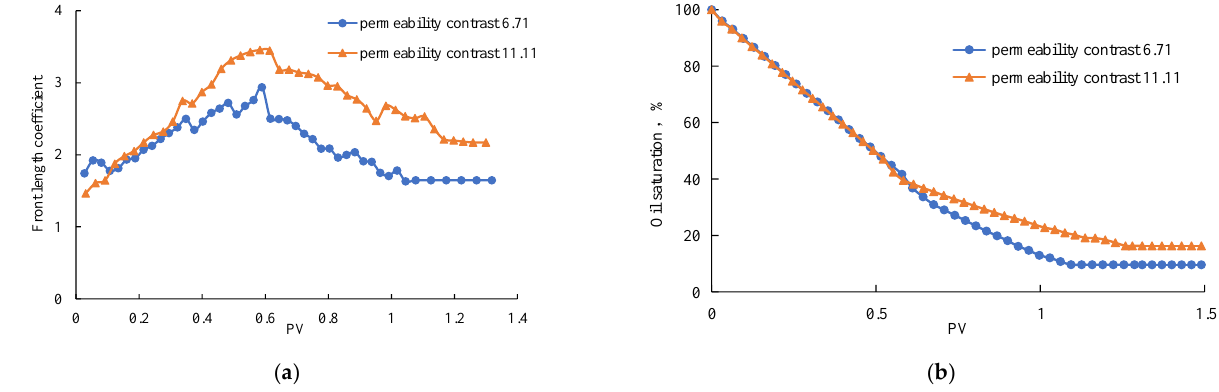
Figure 8. ( a ) Front length coefficient m and ( b ) oil saturation vs. PV for different permeability con- trast.